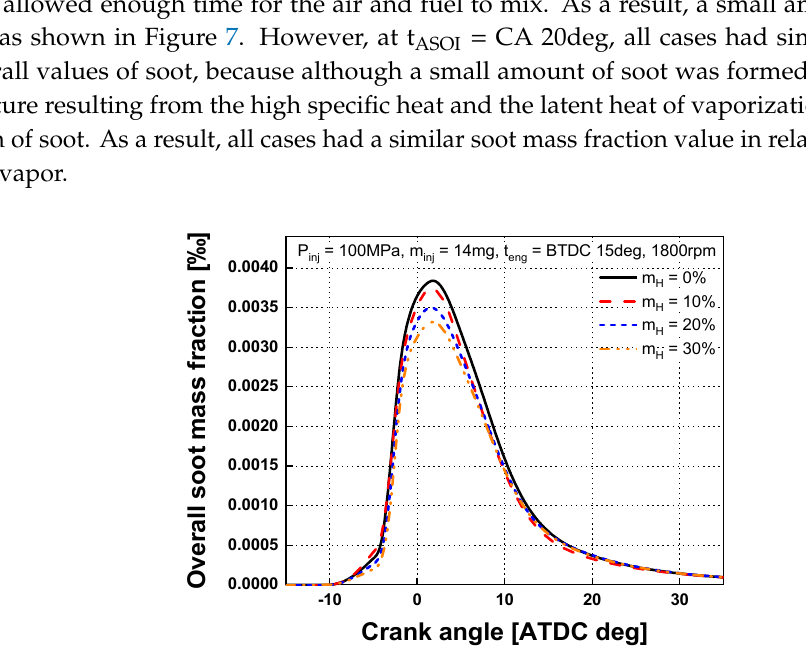
Figure 7. Effect of water vapor portion on the overall soot mass fraction. P inj = 100 MPa, m inj = 14 mg, t eng = BTDC 15deg, 1800 rpm.